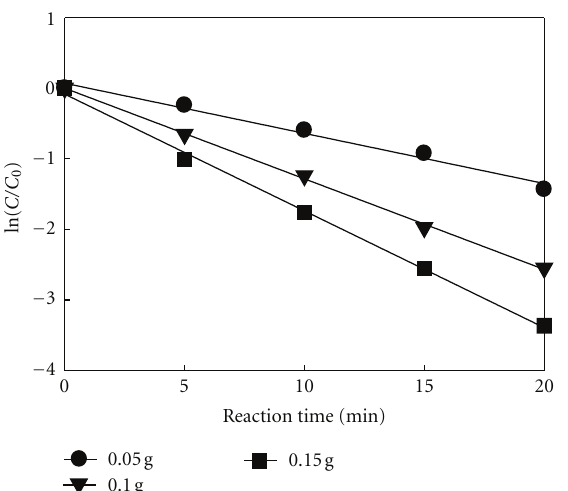
Figure 5: E ff ect of ozone injection on decomposition of